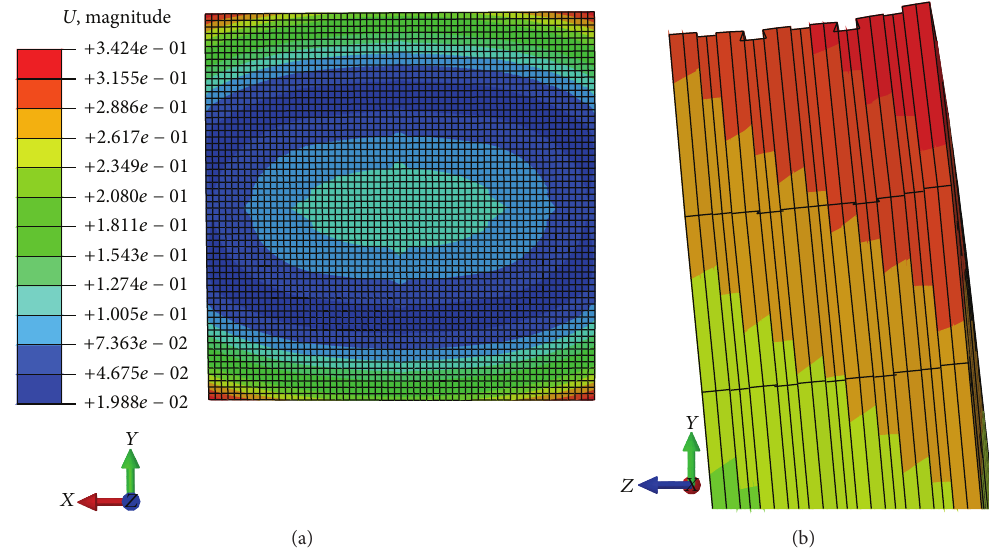
Figure 4: (a) Displacement distribution pattern of laminates at 300 ∘ C, 20MPa; (b) displacement distribution pattern of local laminates at 300 ∘ C, 20